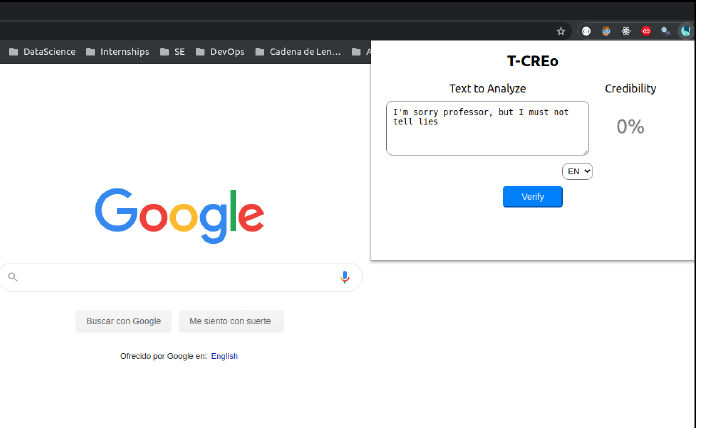
Figure 9. T-CREo front-end as a Google Chrome Extension when opened in any website that is not